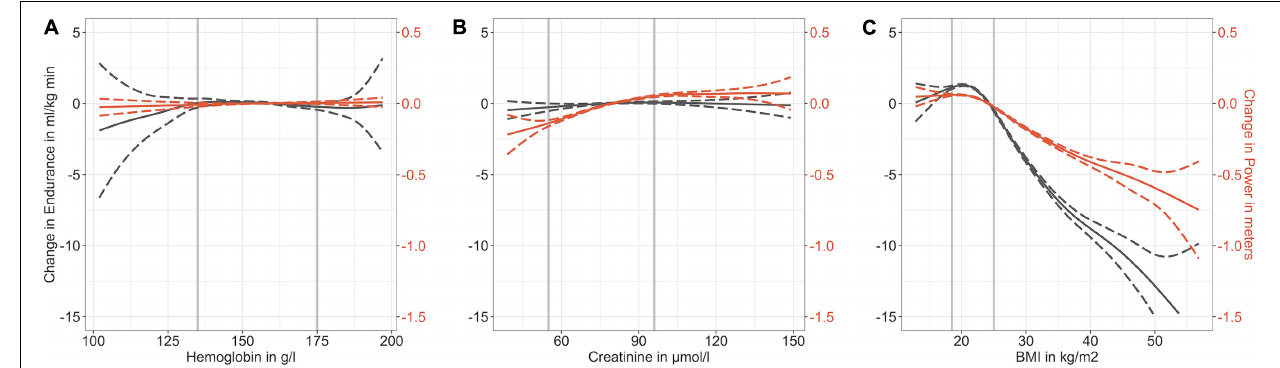
FIGURE 2 | GAM models with smoothed term associations between Hb [g/l] (A) , creatinine [ µ mol/l] (B) , and BMI [kg/m 2 ] (C) on the one hand, and endurance (VO 2max in black) and muscle power performance (Standing Long Jump in red) on the other hand, based on the full dataset after multiple imputation (dashed lines = 95% confidence intervals, gray vertical lines = medical norm thresholds according to the Viollier laboratory lower respectively, upper thresholds: hemoglobin 135 resp. 175 g/l, creatinine 55 resp. 96 µ mol/l, BMI 18.5 resp. 25.0 kg/m 2 ).